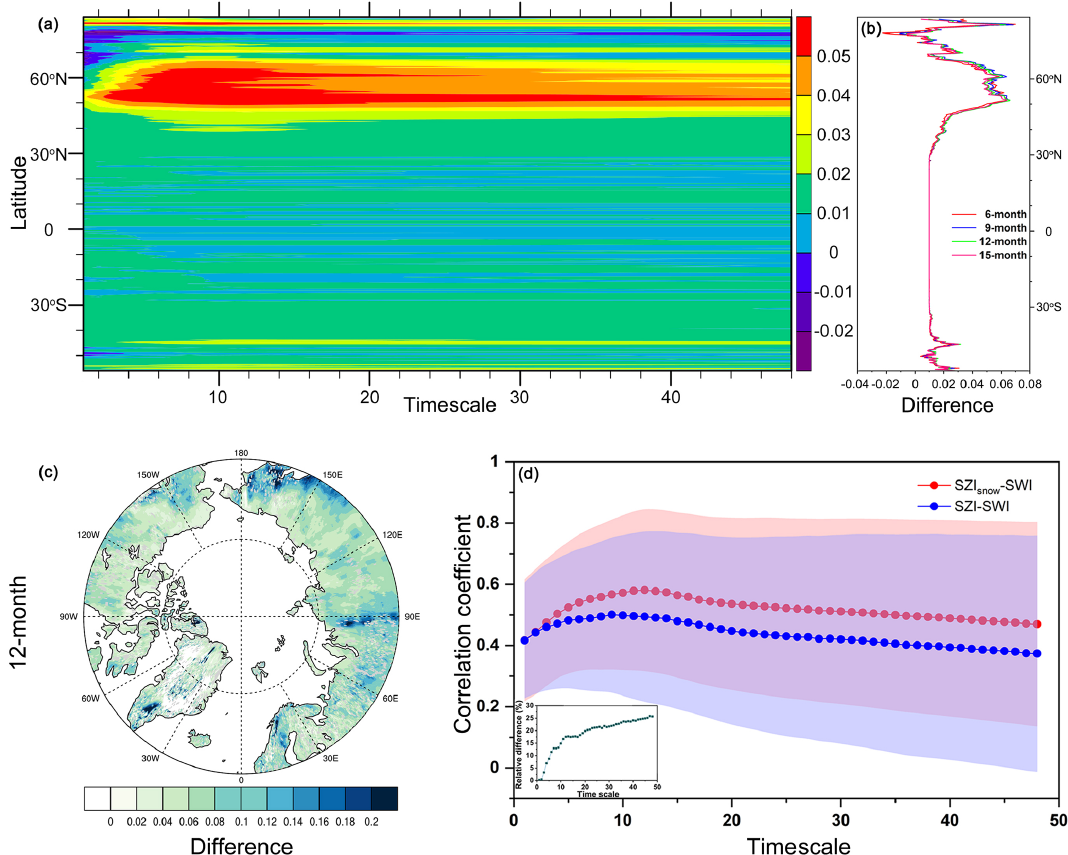
Figure 5. Performance of the SZI snow over different latitudes (a,b) and specifically over the Arctic region (c,d) . Here the differences between the correlation coefficients of the SZI snow –SWI and those of the SZI–SWI for different timescales were used to compare their performance. (a) The Hovmöller diagram (timescale × latitude) shows the differences averaged by latitude from 55 ◦ S to 85 ◦ N for timescales ranging from 1 to 48 months. (b) Distribution of the difference for specific timescales (6, 9, 12, and 15 months) with changing latitude. (c) Spatial distribution of the differences between the correlation coefficients of the SZI snow –SWI and those of the SZI–SWI over a 12-month timescale in the Arctic region. (d) Variations in correlation coefficients averaged over the Arctic region for various temporal scales. The shading denotes the range of correlation coefficients. The upper (lower) boundary is the maximum (minimum) value. The inset shows the change of relative difference (%) for these temporal